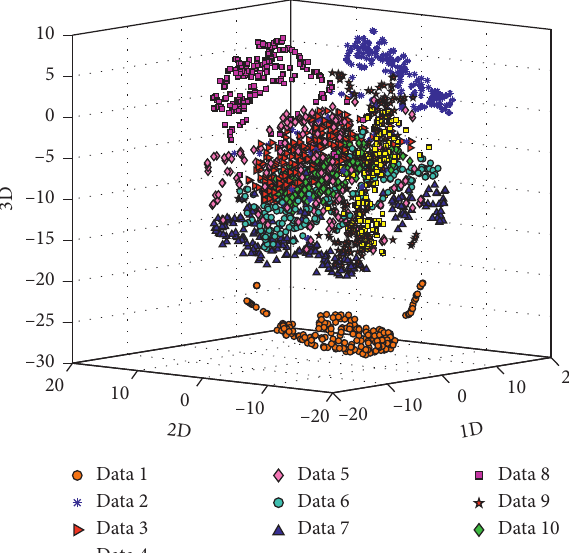
Figure 6: 3D feature scatter diagram of the first hidden layer.